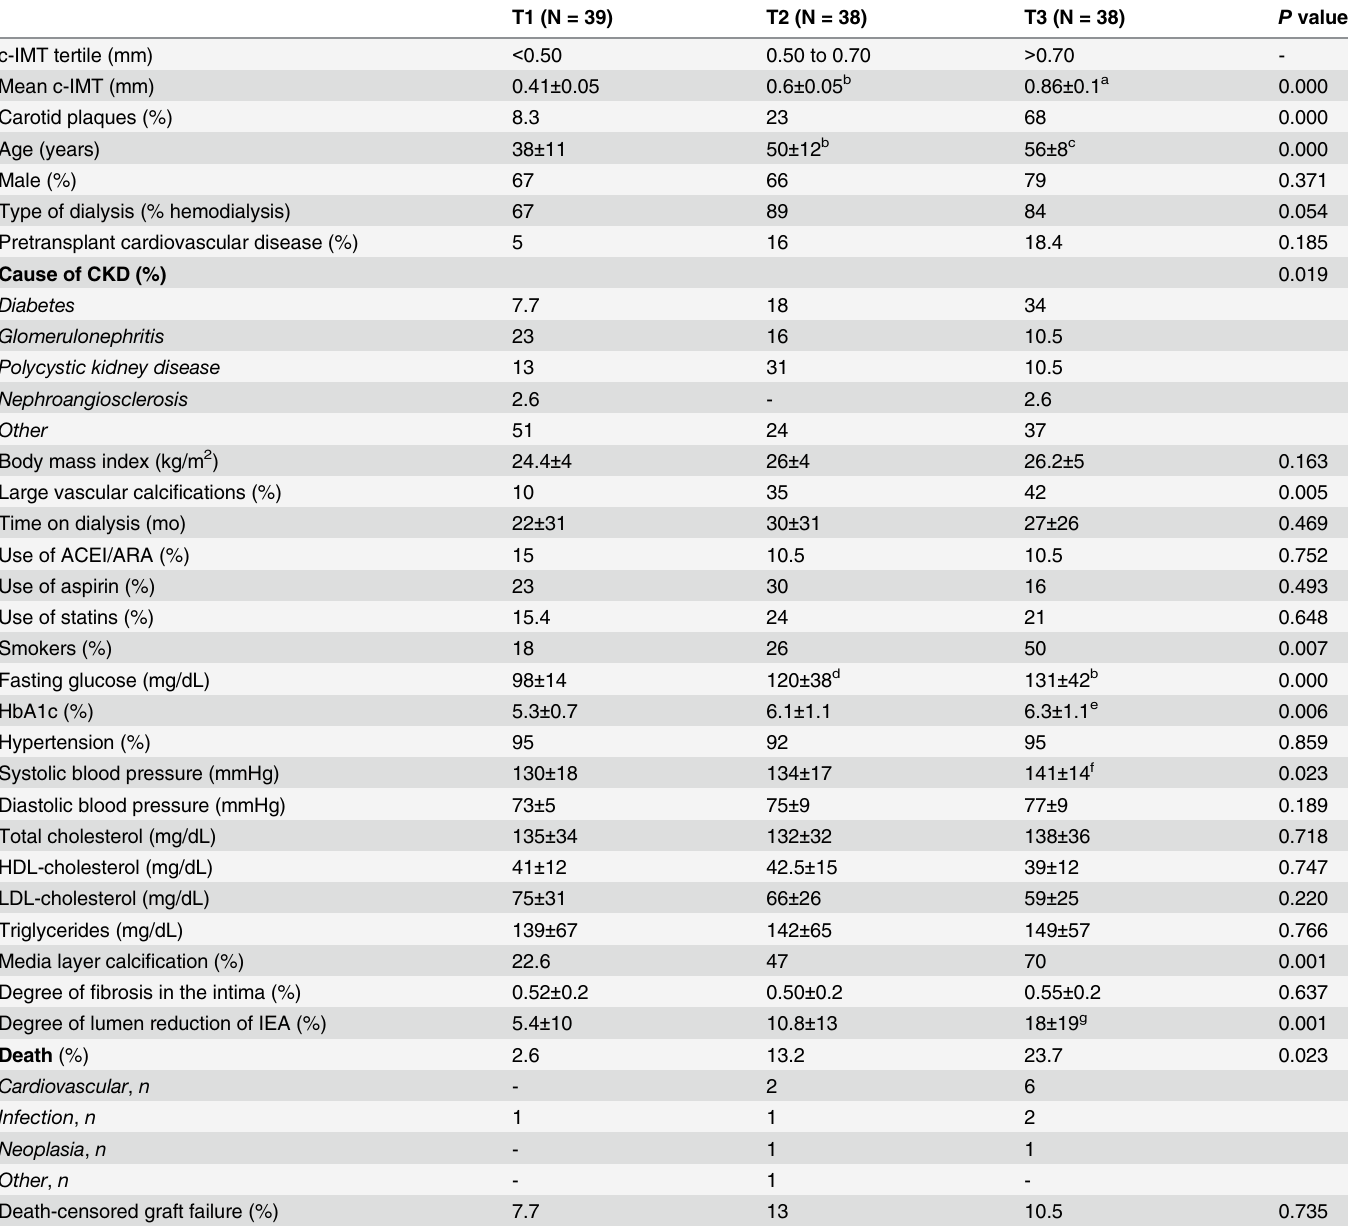
Table 1. Baseline clinical and pathological data of the artery wall in kidney transplant patients according to carotid intima-media thickness